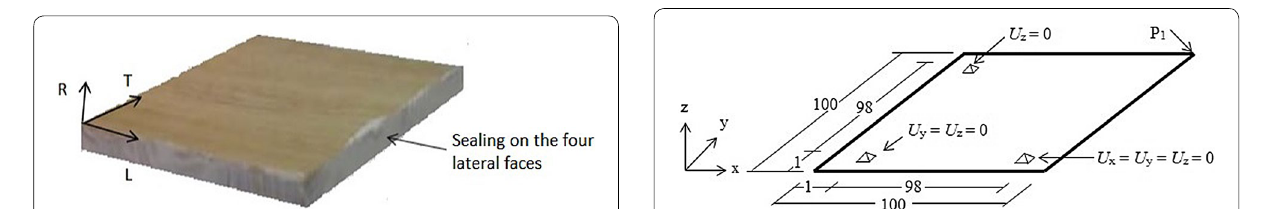
Fig. 5 Boundary conditions on the